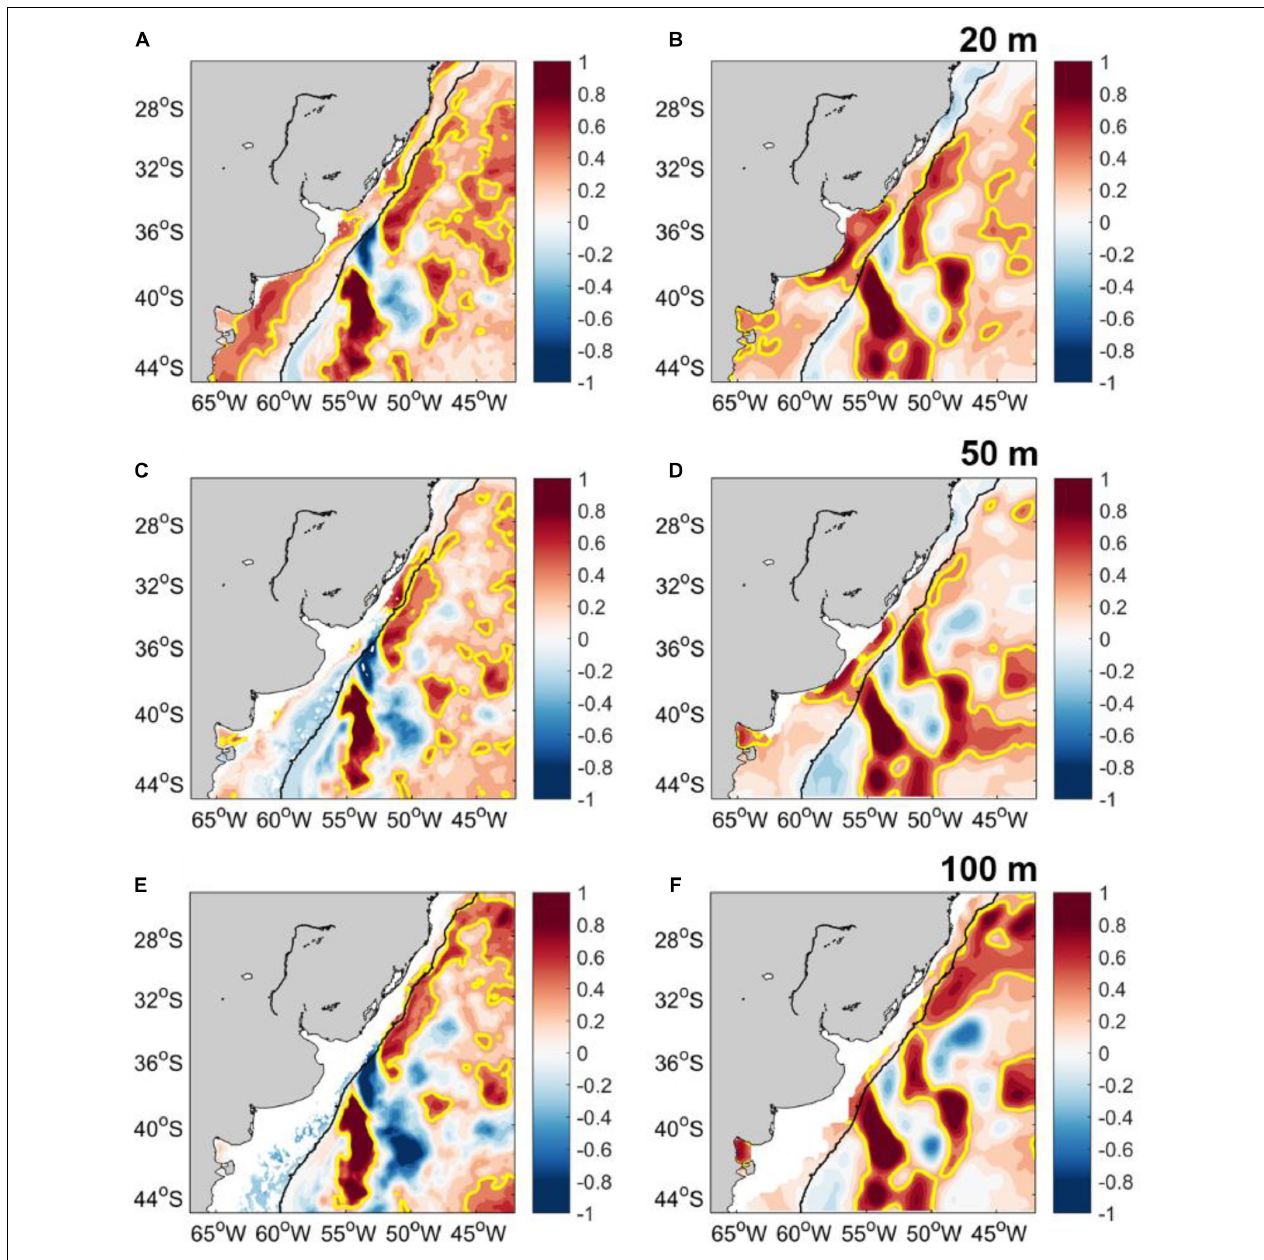
FIGURE 4 | GLORYS12 temperature trend ( ◦ C/decade) during 2003–2017 at (A) 18 m, (C) 47 m, and (E) 92 m. ARMOR3D trend ( ◦ C/decade) at (B) 20 m, (D) 50 m, and (F) 100 m. The yellow contour corresponds to the 0.4 ◦ C/decade isoline. The 200 m isobath is shown in